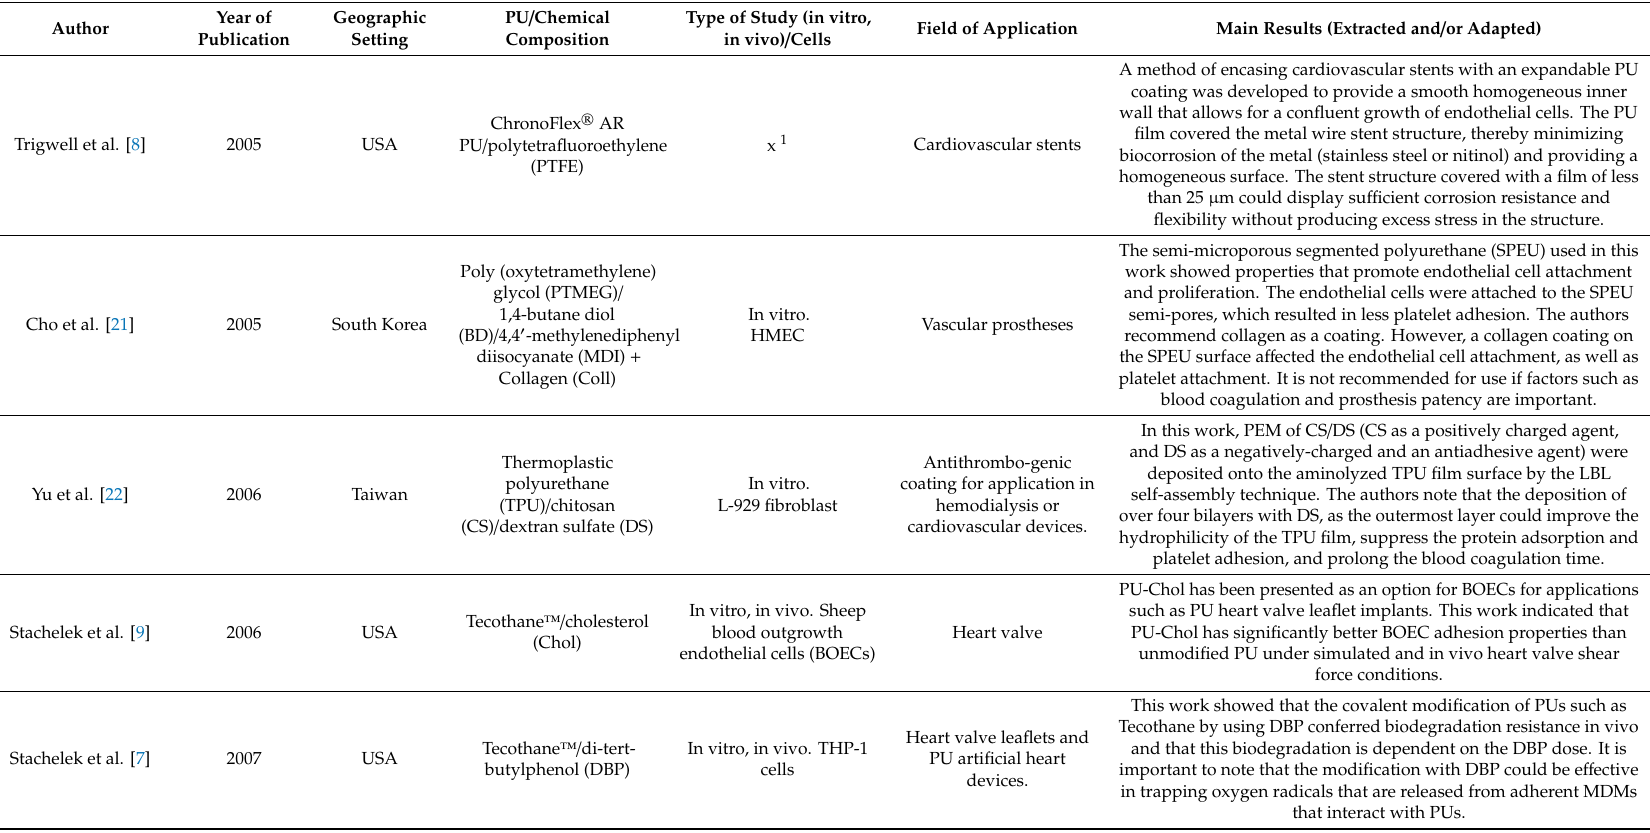
Table 1. Characteristics and results of Included